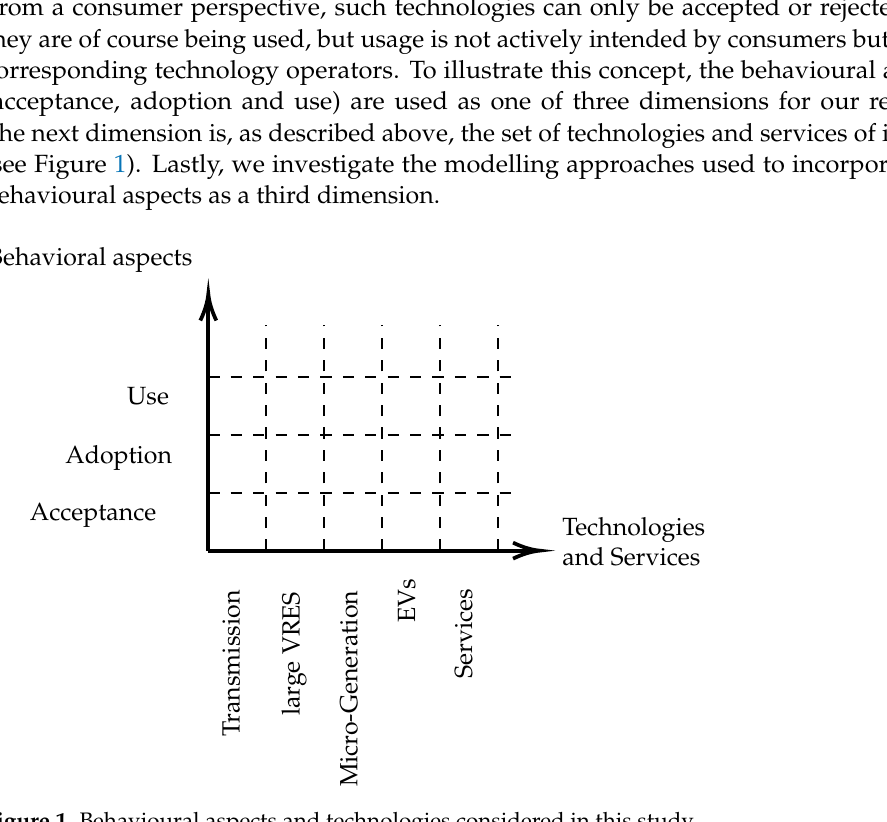
Figure 1. Behavioural aspects and technologies considered in this